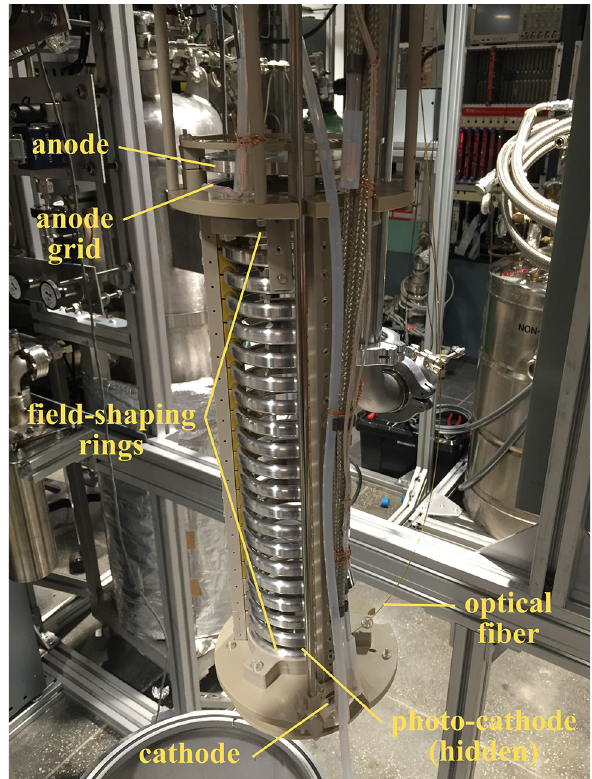
Fig. 3 The Xeclipse Purity Monitor (PM). The field-shaping rings from the XENON1T Demonstrator [19] surround the parallel-grid ion- ization chamber. The thin, gold-colored optical fiber is shown along the right side of the PM, curving in to face the photo-cathode